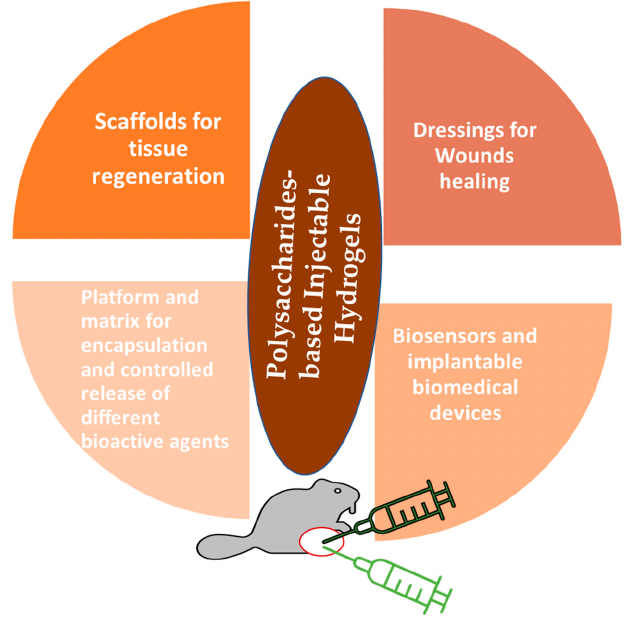
Figure 2. Different applications of polysaccharide-based injectable hydrogels (PSIHs).